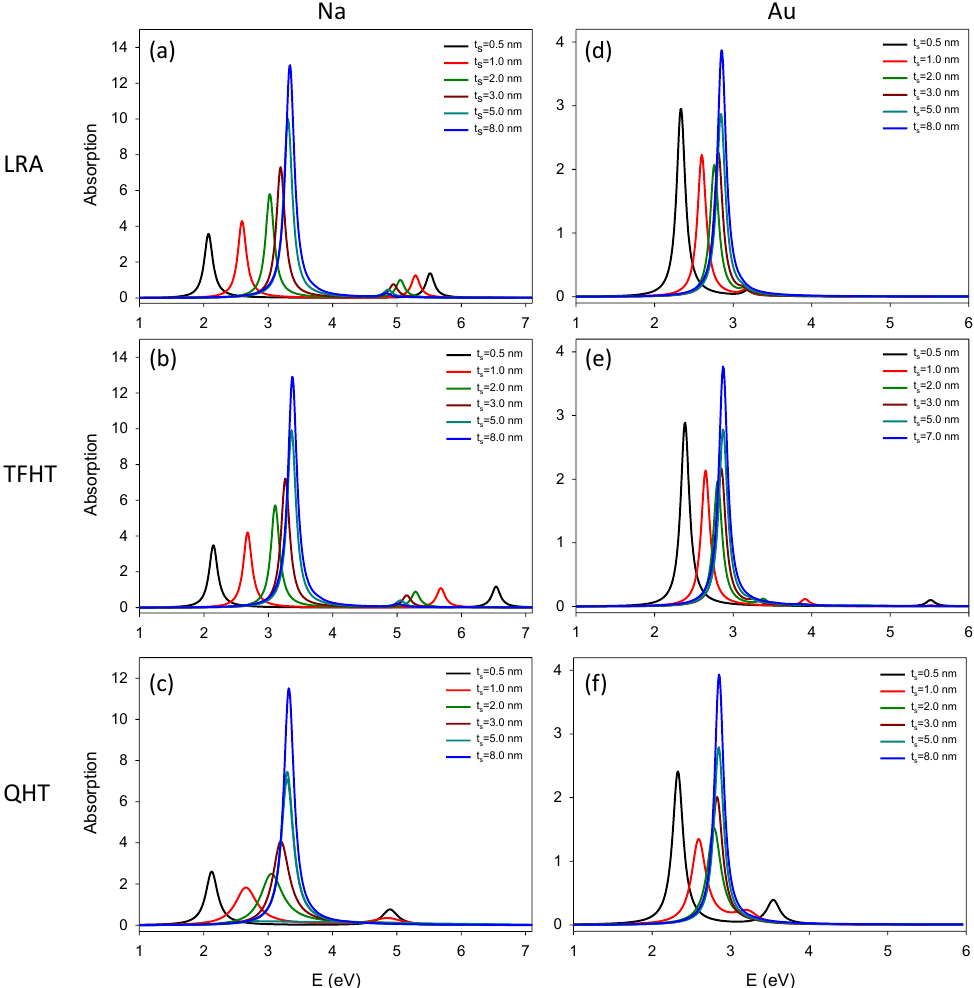
Figure 5. Absorption spectra for Na (left panel) and Au (right panel) nanoshell calculated within different theories for different shell thicknesses t s = R 2 − R 1 with a fixed core radius R 1 = 2